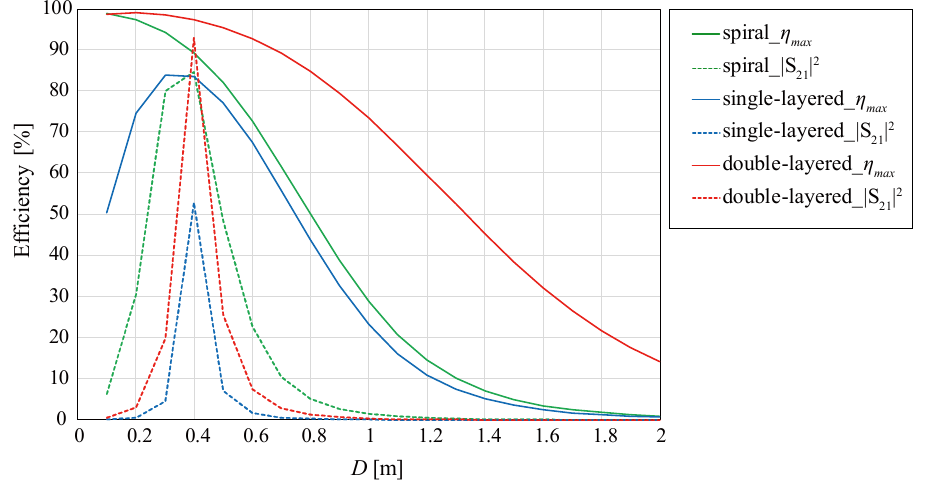
Figure 7. Transfer distance characteristics of transfer efficiency.